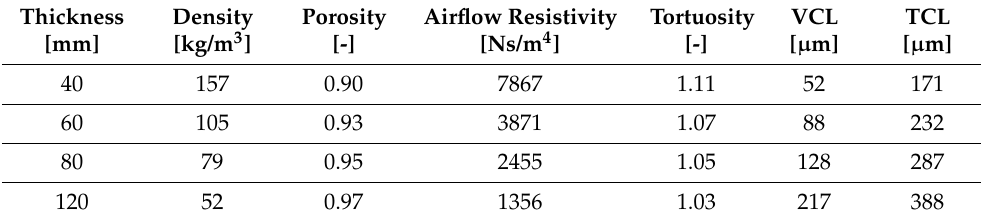
Table 1. Physical parameters of the JCA model calculated with the proposed analytical relationships.